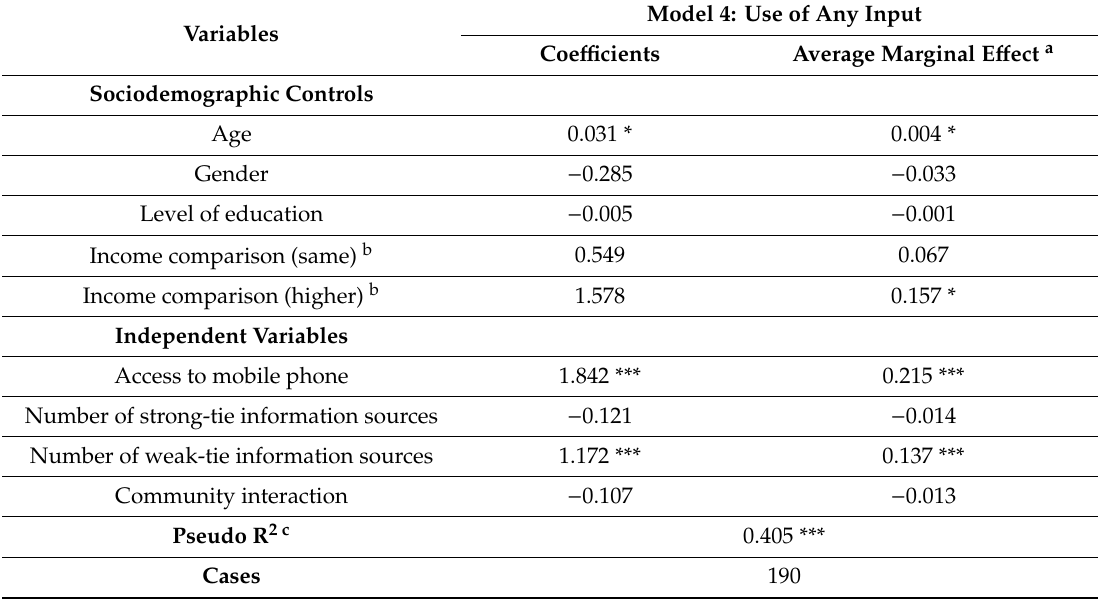
Table 3. Logistic regression model of any input